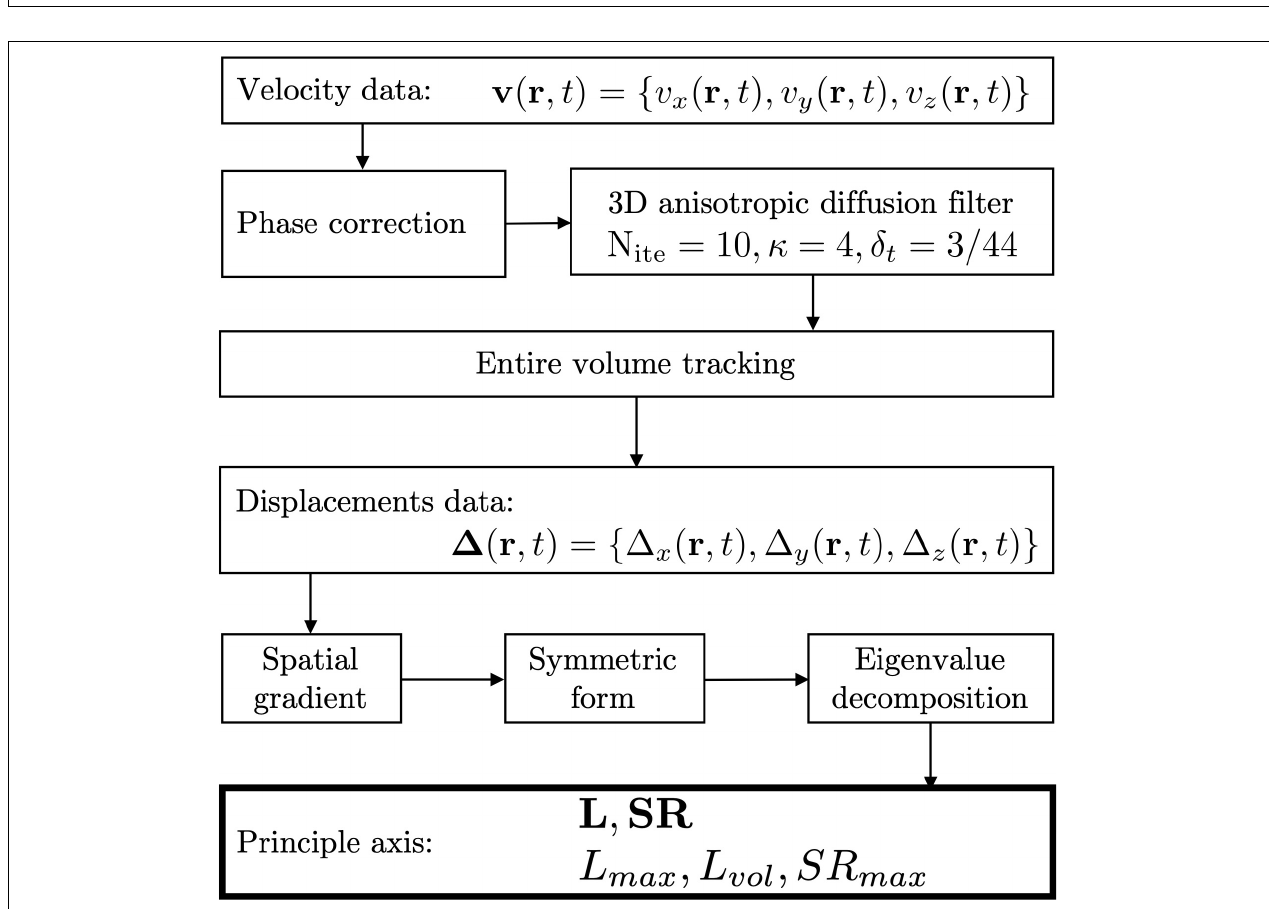
FIGURE 1 | Flowchart showing the CS undersampling pattern, acquisition parameters, and the non-linear reconstruction including the sparse transforms employed here. Coil sensitivity maps derived from the multi-coil k -space data is integrated into the reconstruction and is shown for the eight channels of the 8-channel receive coil.